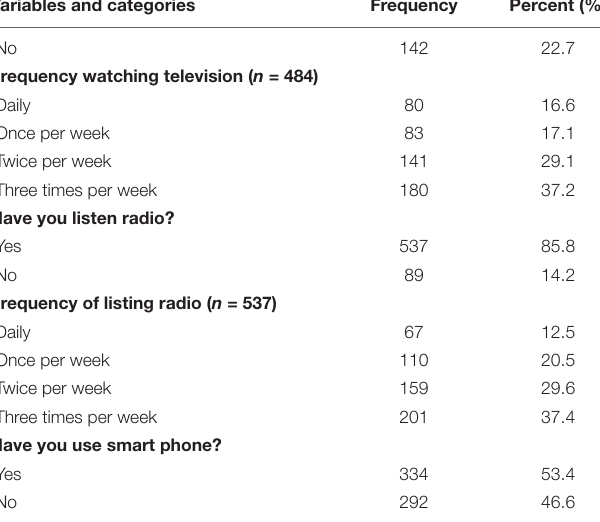
TABLE 1 | Sociodemographic characteristics of study participants in Gondar city, Northwest Ethiopia, 2021 ( n =